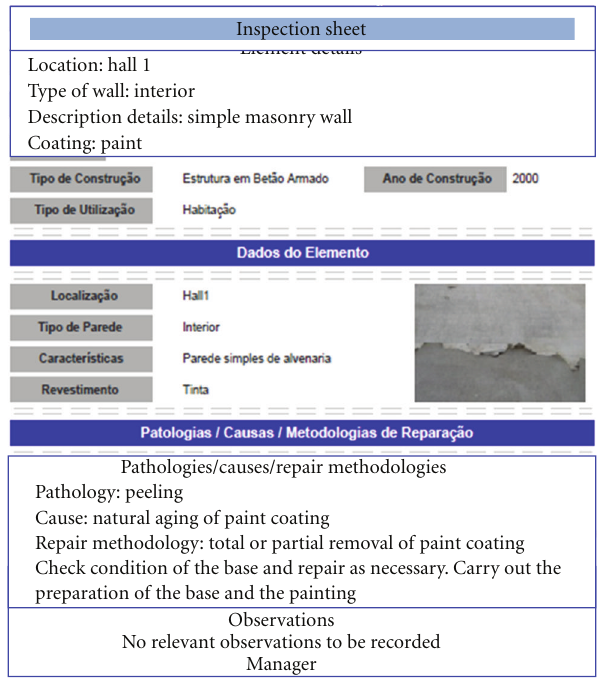
Figure 6: Inspection